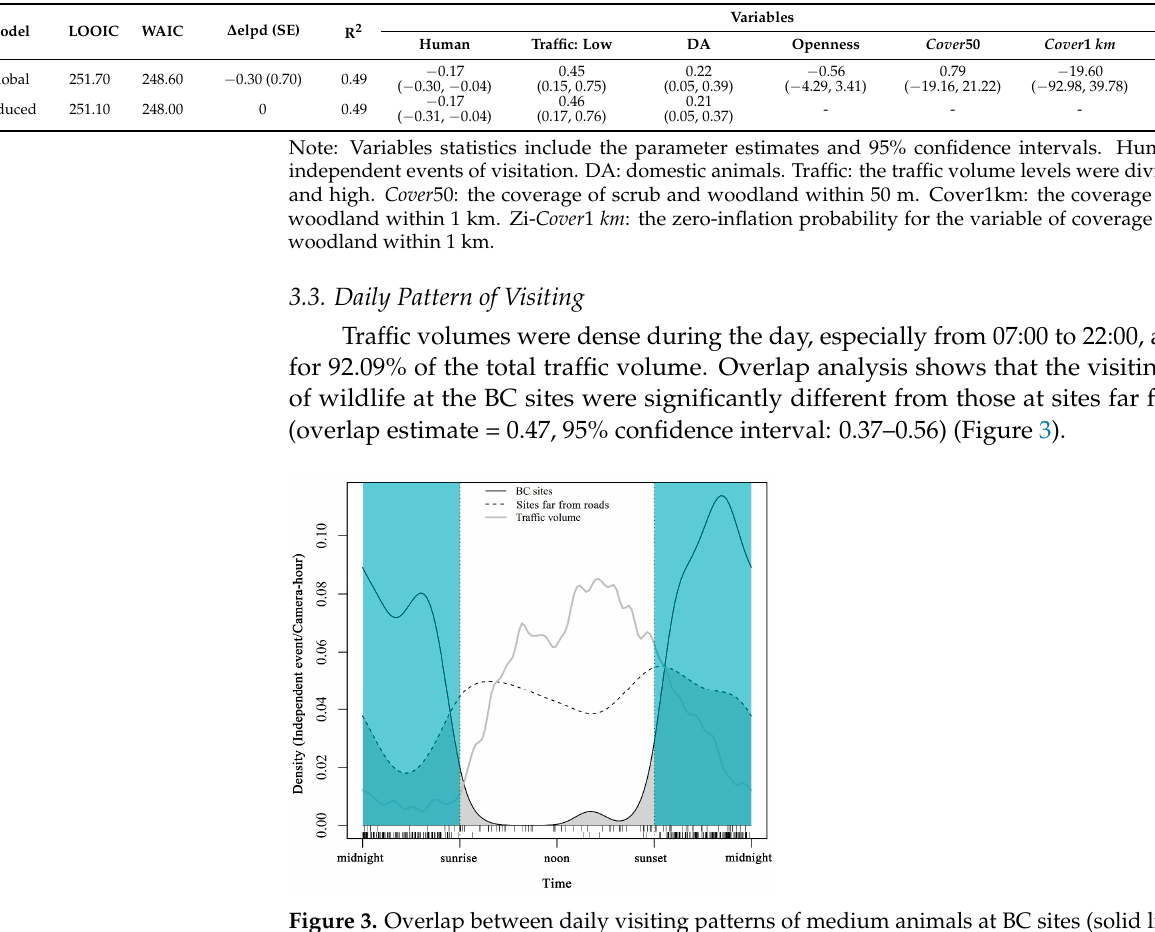
Figure 3. Overlap between daily visiting patterns of medium animals at BC sites (solid line) and the sites far from roads (dotted line). The grey line shows the traffic volume along the road. Time of day is presented on the x-axis. The thin dotted line represents the standardized sunrise time and sunset time respectively. The blue area in the figure represents night time.